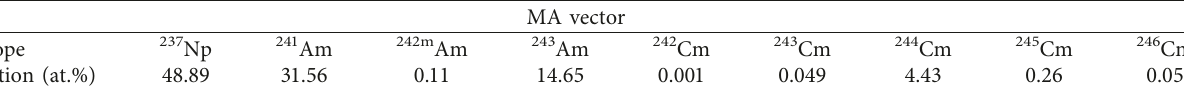
Figure 2: One-sixth model of the VVER-1000 LEU fuel assembly with Table 2: MA vector of VVER-440 spent fuel.